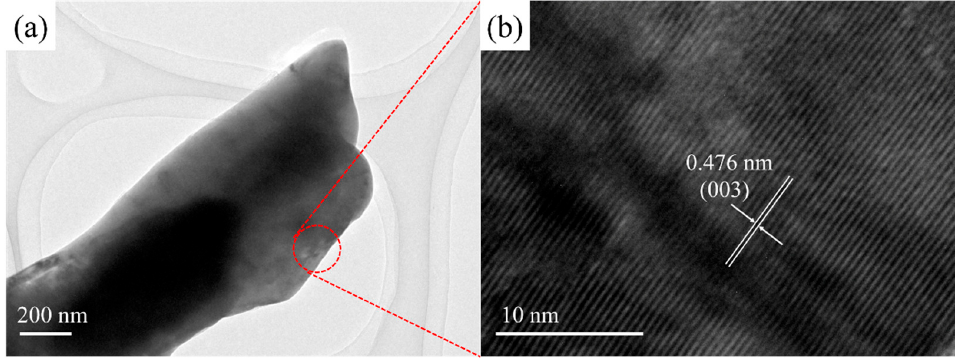
Figure 6. ( a ) TEM and ( b ) HRTEM images of NCM800.